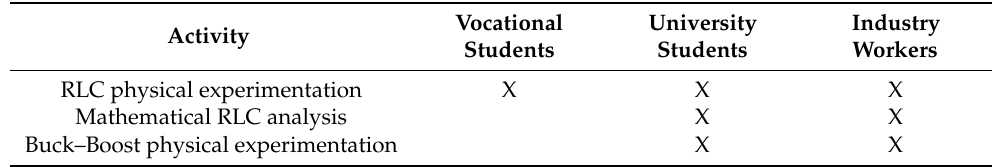
Table 1. Participants using the AR-electronics